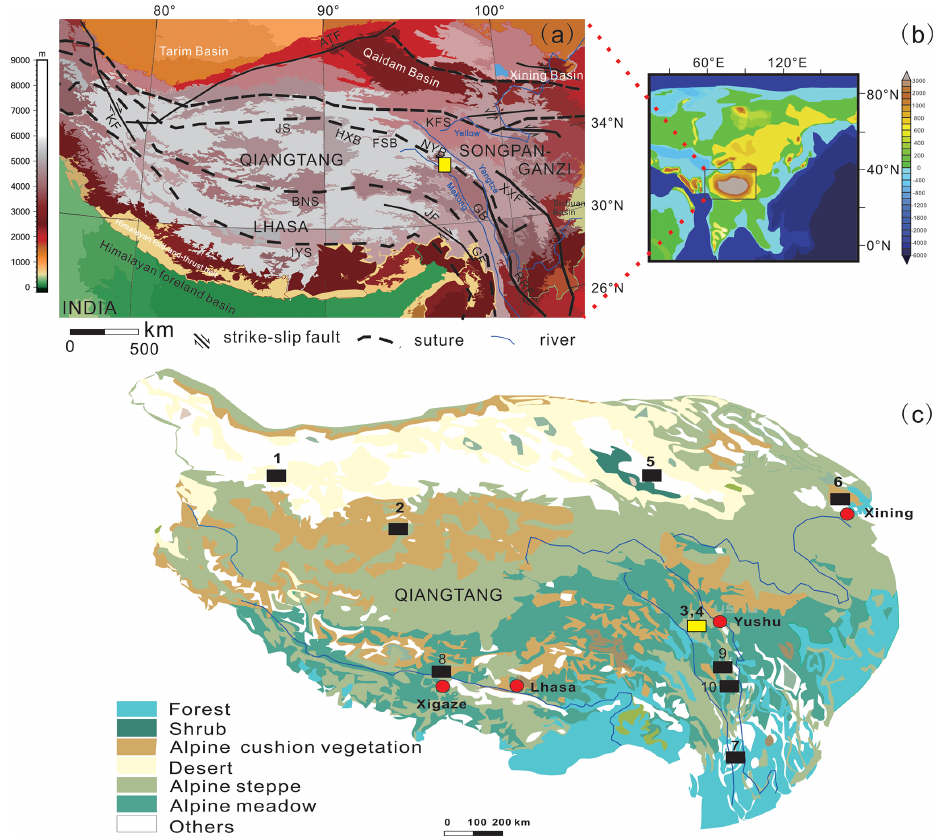
Figure 1. (a) Tectonic map of the Tibetan Plateau (TP) indicating the major sedimentary basins (HXB: Hoh Xil Basin; FSB: Fenghuo Shan basins; NYB: Nangqian-Yushu basins; GB: Gongjo Basin), sutures (JS: Jinsha Suture; BNS: Bangong-Nujiang Suture; IYS: Indus-Yalu Suture), and major faults (KF: Karakorum Fault; ATF: Altyn Tagh Fault; KFS: Kunlun Fault system; XXF: Xiangshuihe–Xiaojiang Fault system; RRF: Red River Fault; GF: Gaoligong Fault; JF: Jiali Fault), redrawn following Horton et al. (2002). The yellow rectangle indicates the location of this study in the Nangqian Basin. (b) A late-middle Eocene (40Ma) palaeogeographic reconstruction, with the Qinghai– Tibetan region indicated by a black rectangle (redrawn following Tardif et al., 2020). (c) Modern vegetation distributions on the Tibetan Plateau, with major towns indicated in red (redrawn following Baumann et al., 2009). Numbers indicate the positions of palynological assemblages that are correlated in Fig. 4 and the text: 1, Tarim Basin; 2, Hoh Xil Basin; 3 and 4, Nangqian Basin (this study is indicated by a yellow rectangle); 5, Qaidam Basin; 6, Xining Basin; 7, Jianchuan Basin; 8, Xigaze Basin; 9, Markam Basin; and 10, Gonjo